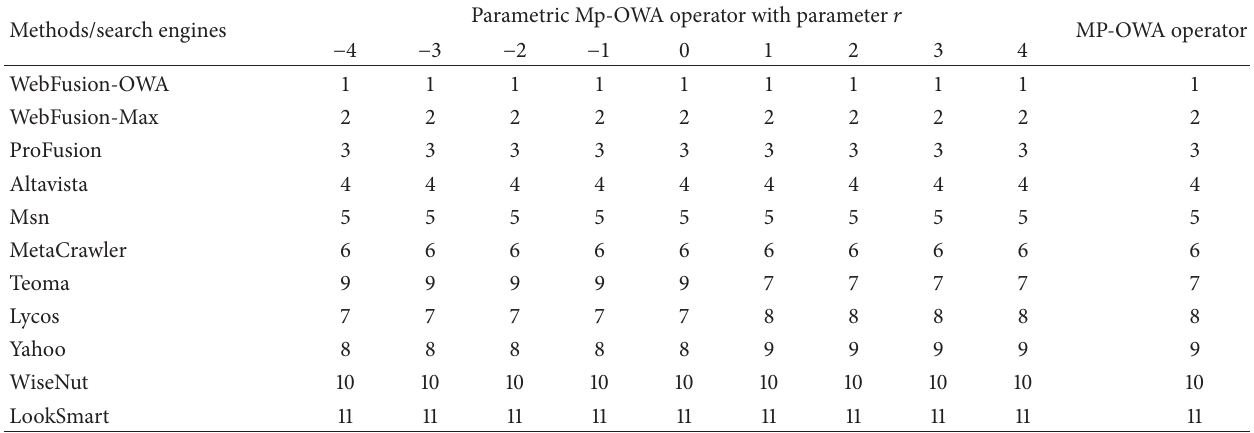
Table 7: Comparison of ranks given to search engines with different values of parameter 𝑟 . Parametric Mp-OWA operator with parameter Methods/search engines